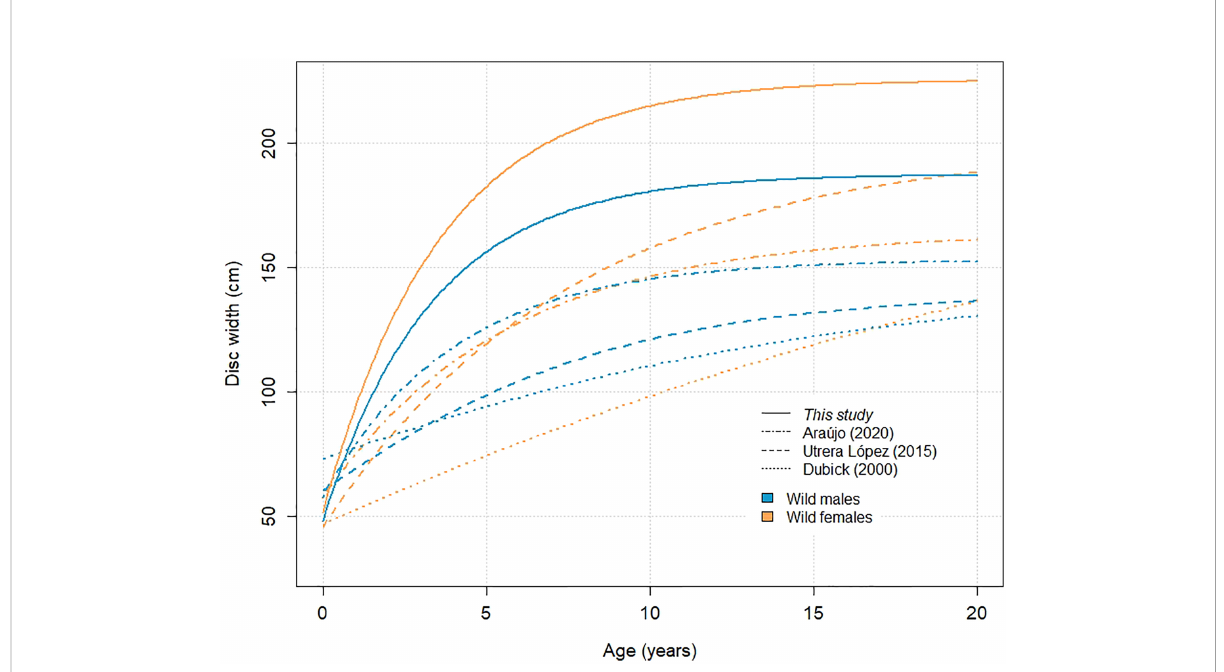
FIGURE 5 Von Bertalanffy growth curves generated for wild A. narinari. Parameters for female curves: DW ∞ = 225.7 cm, k = 0.28 year -1 (this study); DW ∞ = 164.2 cm, k = 0.18 year -1 (Arau ́ jo, 2020); DW ∞ = 200.0 cm, k = 0.13 year -1 (Utrera-Lo ́ pez, 2015); DW ∞ = 245.9 cm, k = 0.03 year -1 (Dubick, 2000). Parameters for male curves: DW ∞ = 187.6 cm, k = 0.30 year -1 (this study); DW ∞ = 153.3 cm, k = 0.25 year -1 (Arau ́ jo, 2020); DW ∞ = 140.0 cm, k = 0.18 year -1 (Utrera-Lo ́ pez, 2015); DW ∞ = 146.5 cm, k = 0.09 year -1 (Dubick,